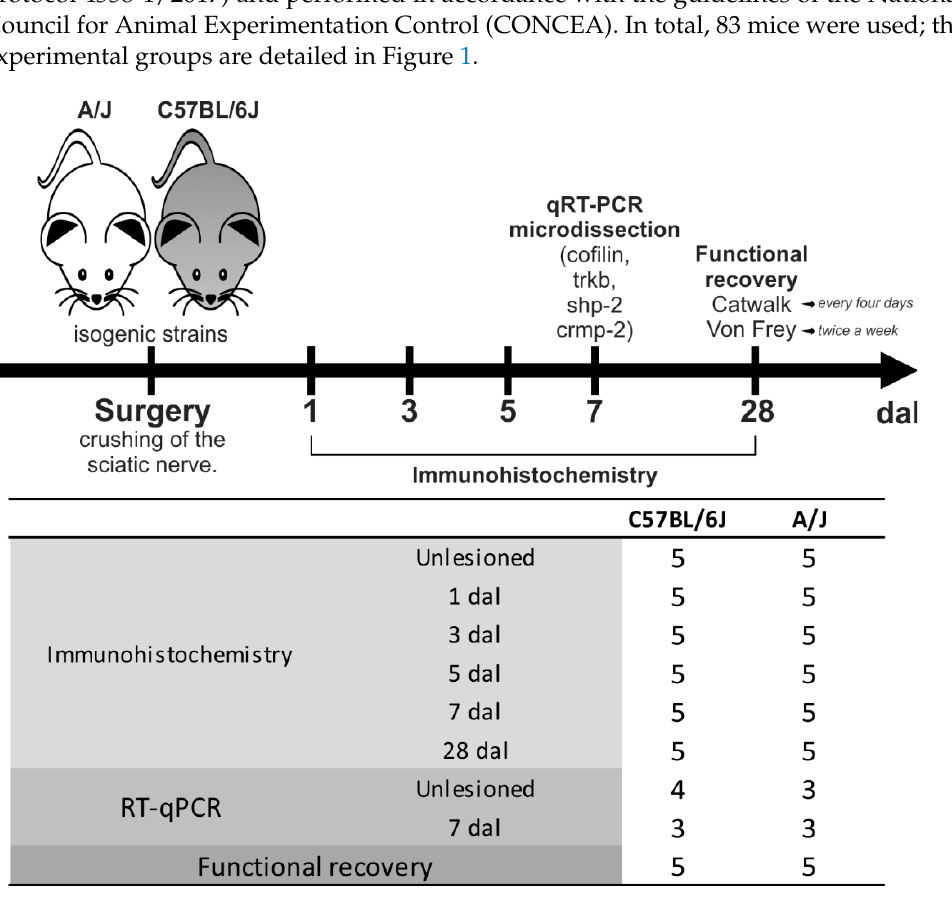
Figure 1. Schematic drawing and detailed distribution of animals used for experimentation, ordered by strain, according to the technique applied. For immunohistochemistry and RT–qPCR, groups with different survival periods after sciatic nerve crush were analyzed. Uninjured animals were used as controls. Dal: days after lesion.